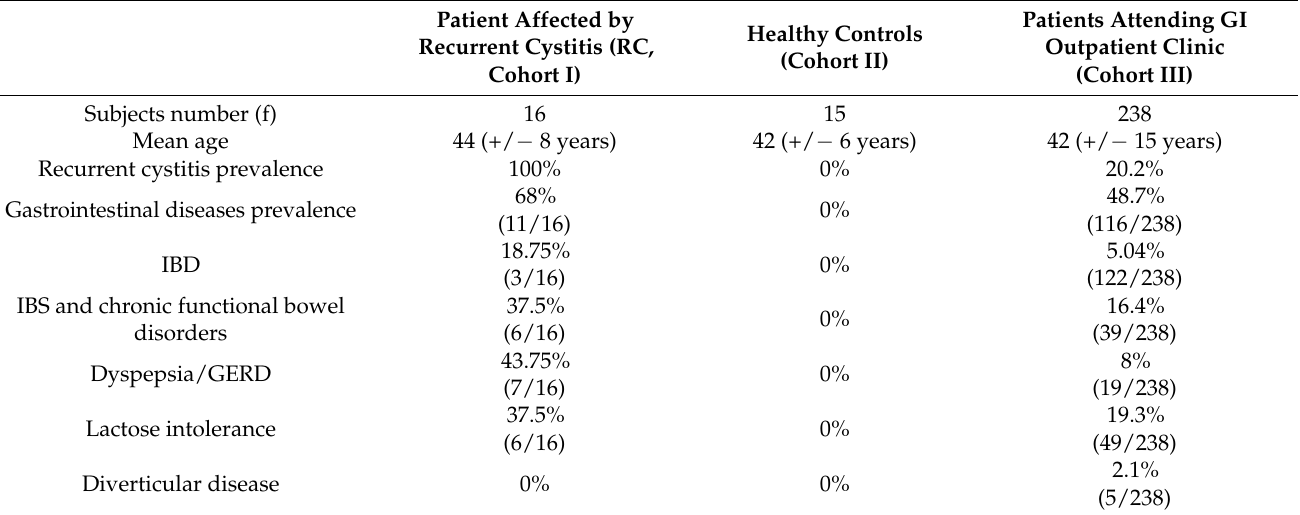
Table 1. The demographic characteristics and medical history of patients in the RC and gastrointesti- nal cohort and of healthy controls are